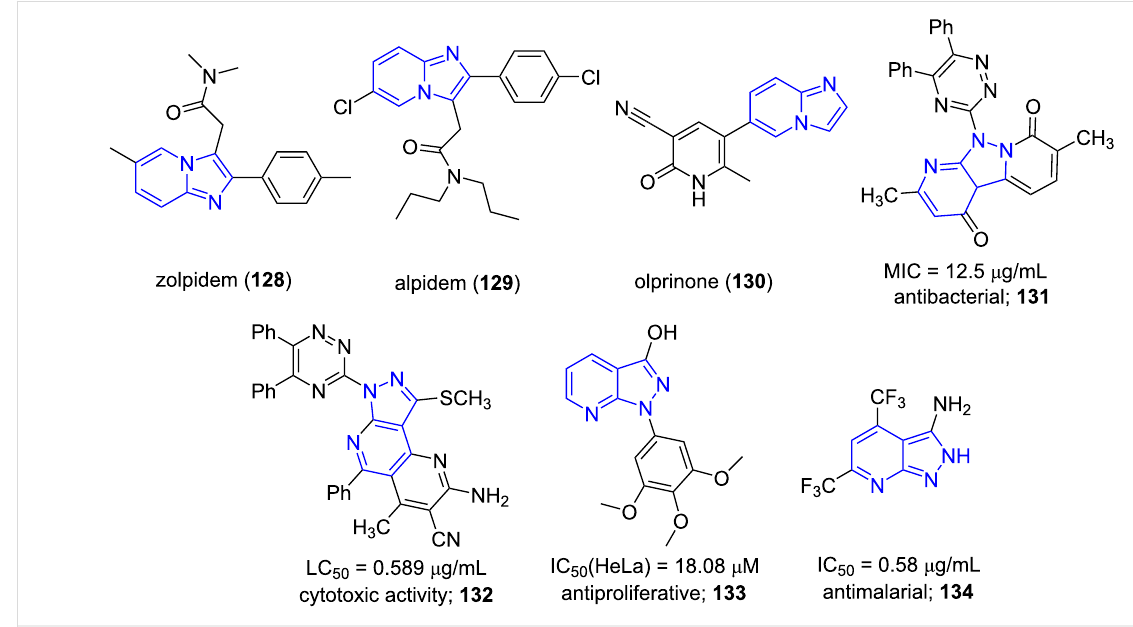
Figure 10: Biologically active fused